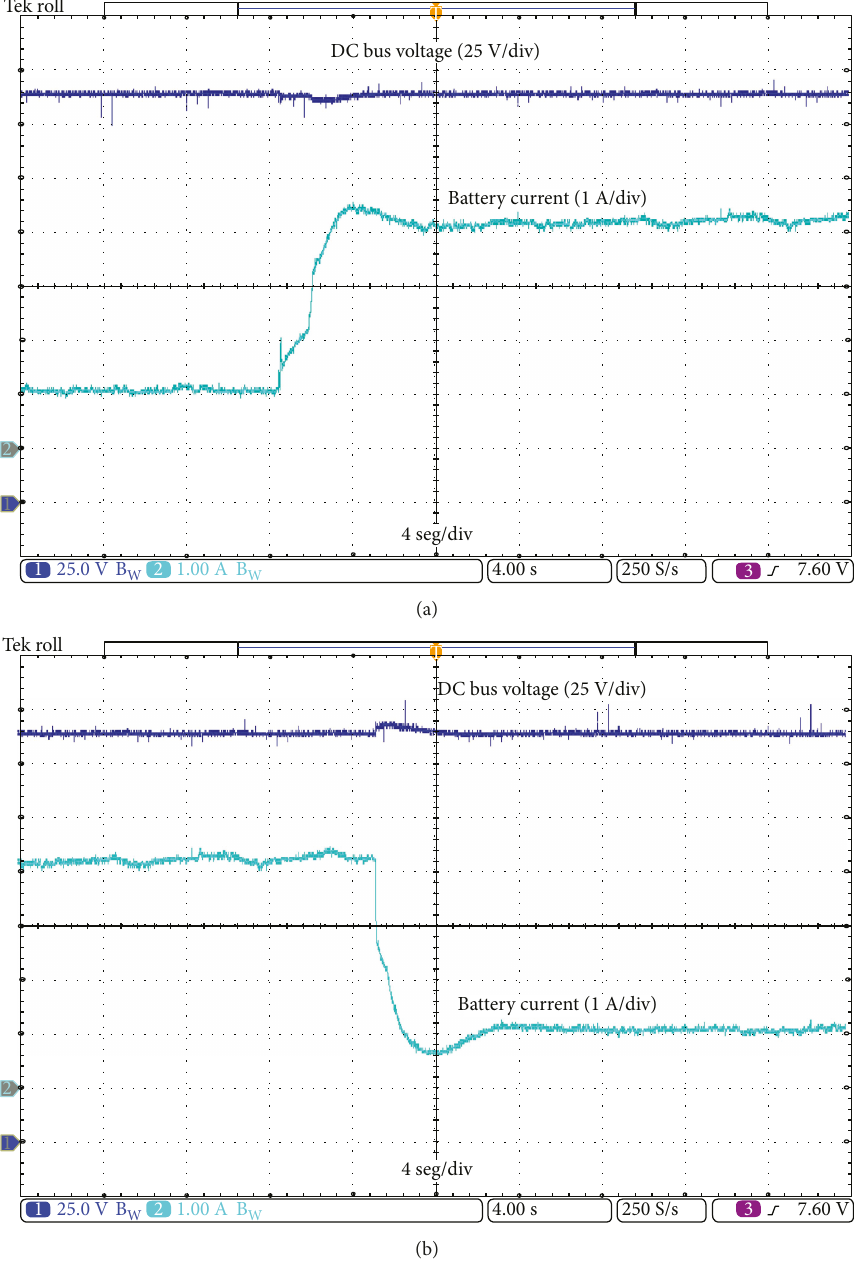
Figure 13: (a) Connection of 500 W fl uorescent lamps and (b) disconnection of 500W fl uorescent